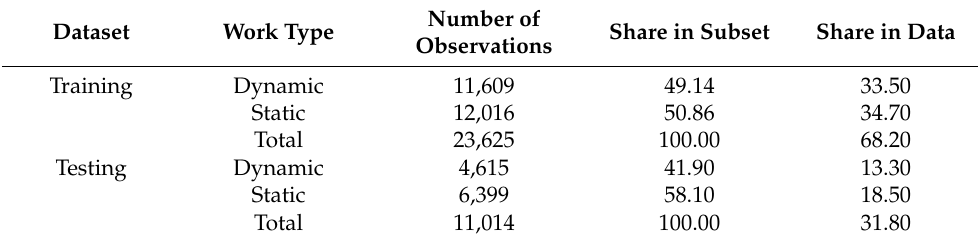
Table 2. Description of the data subsets used for training and